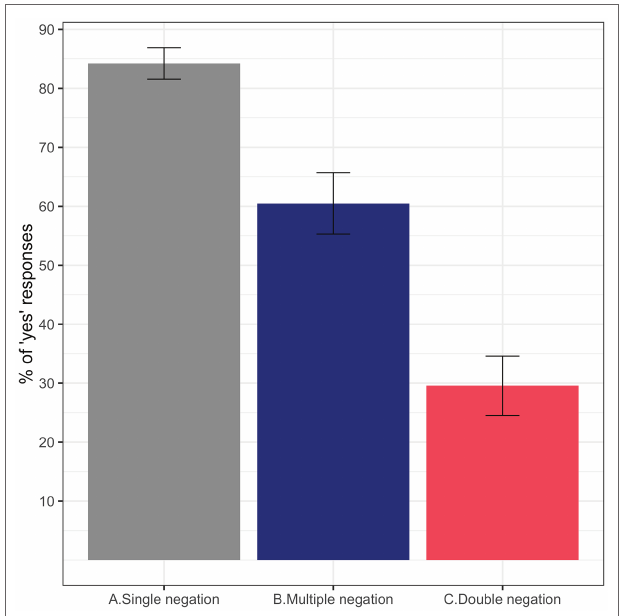
FIGURE 1 | Average percentage of “YES” responses for the experimental conditions aggregated by participant (Experiment 1). Error bars indicate standard error of the